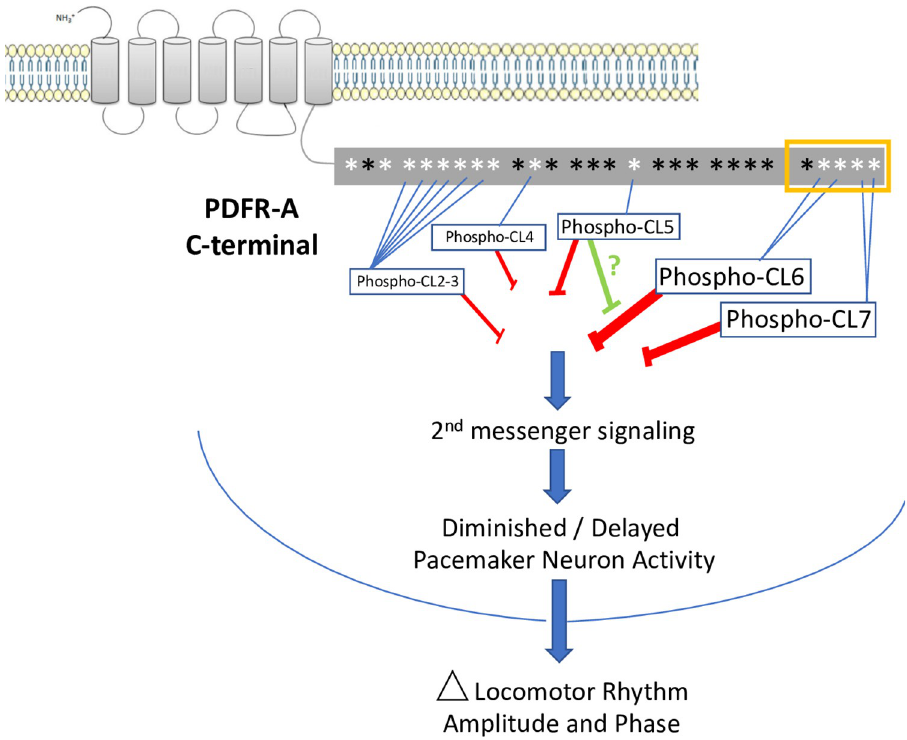
Fig 7. A model predicting the effects of phosphorylating different sites on the PDFR CT on downstream signaling. The CT is diagrammed as a grey box running horizontally. Asterisks indicate the positions Ser/ Thr/ and Tyr residues as described in Fig 1 and S1 Fig : white asterisks are the subset of Ser/Thr/ and Tyr residues that were targets of mutational analysis in this study. Mutation of CL6 and CL7 consistently demonstrated the greatest delaying effects on the phases of Evening locomotor peaks; they were also among the sites with greatest influence on the amplitudes of the Morning and Evening peaks. The results suggest their phosphorylation normally will have the greatest effect to slow or terminate PDFR signaling. Other sites are also effective, although to lesser degrees (as indicated by their font sizes), including CL2-3, CL4 and CL5. Primarily, such phosphorylation will decrease the duration of PDFR signaling (red bars) and so reduce (for example) the delay that PDF imposes on the period of neuronal activation displayed by PDFR-responsive pacemaker groups (like the Evening cells and the DN3 [10, 19]). The model also predicts that the effects of phosphorylating CL5 will depend on the phosphorylation status of neighboring sites. In some contexts (e.g., PDFR 1-5A), it will help terminate PDFR signaling, but in others (e.g., PDFR 567A) it may promote the duration or extent of PDFR signaling, perhaps by blocking the effects of phosphorylating CL6 and CL7 (green bar).